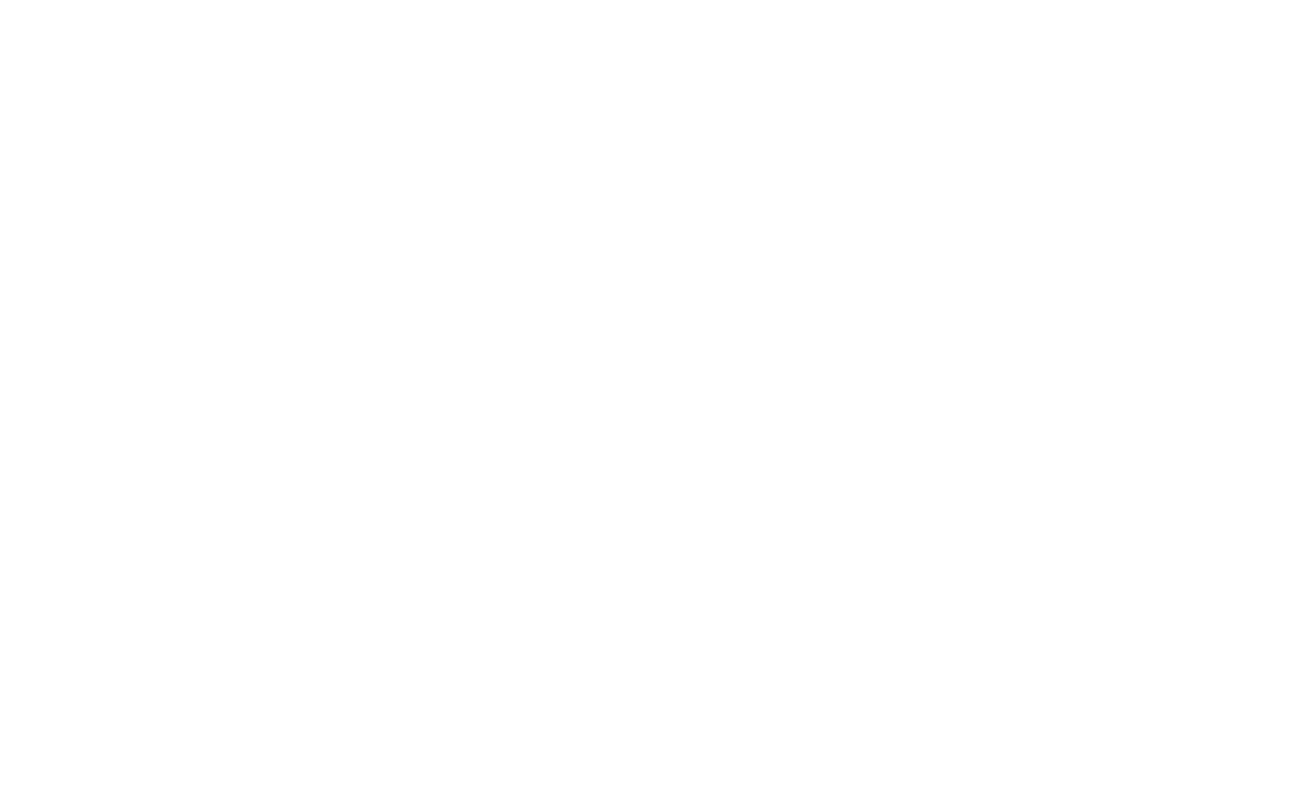
Frontiers in Neuroanatomy |